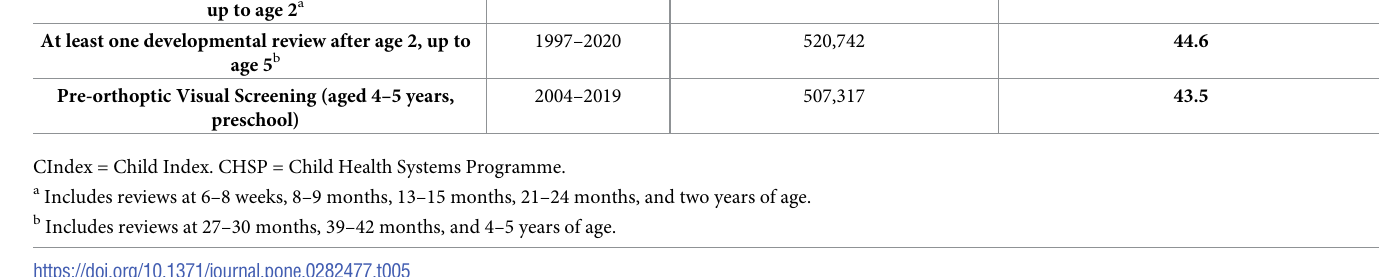
Number of live borns from SMR02 % all live borns from SMR02 (with CIndex) data reviewed